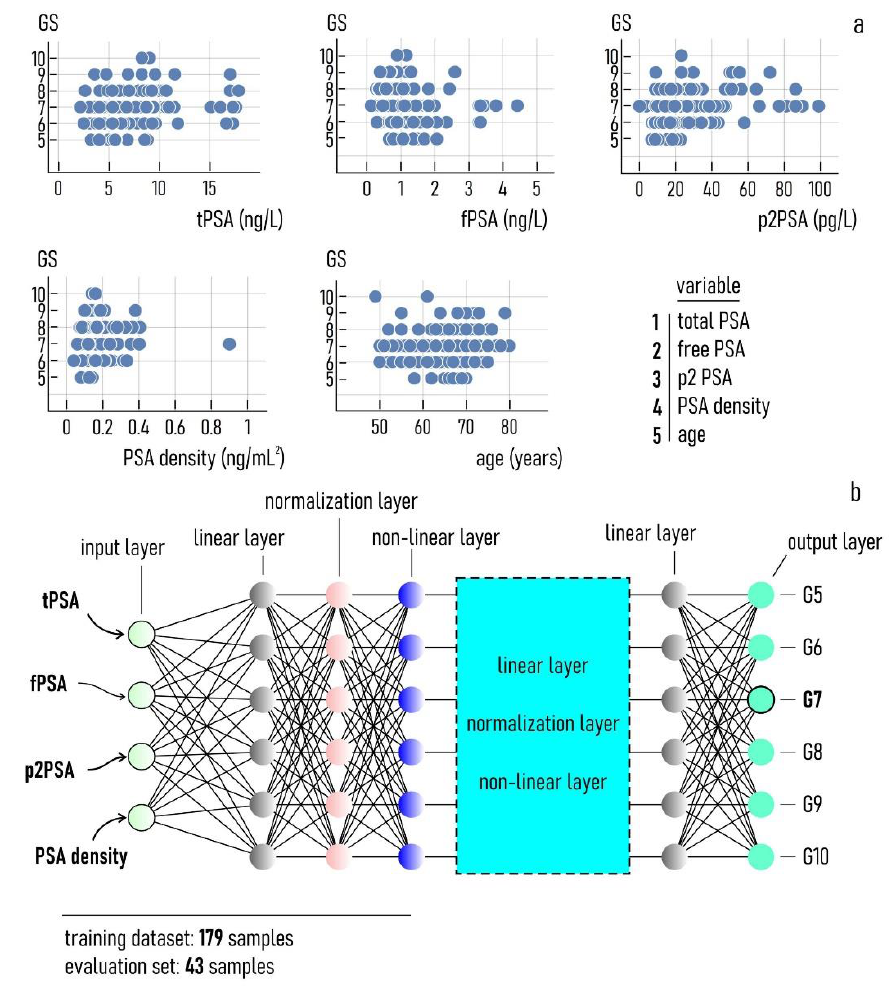
Figure 2. Gleason score reported as a function of several different clinical variables and age used in this study ( a ). The artificial neural network (ANN) used to analyze data and build a predictive model of PC aggressiveness. The network receives as an input the values of the 4 clinical variables of the study. These variables are combined together through successive layers and transmitted to an output layer which determines the grade of the cancer ( b ).